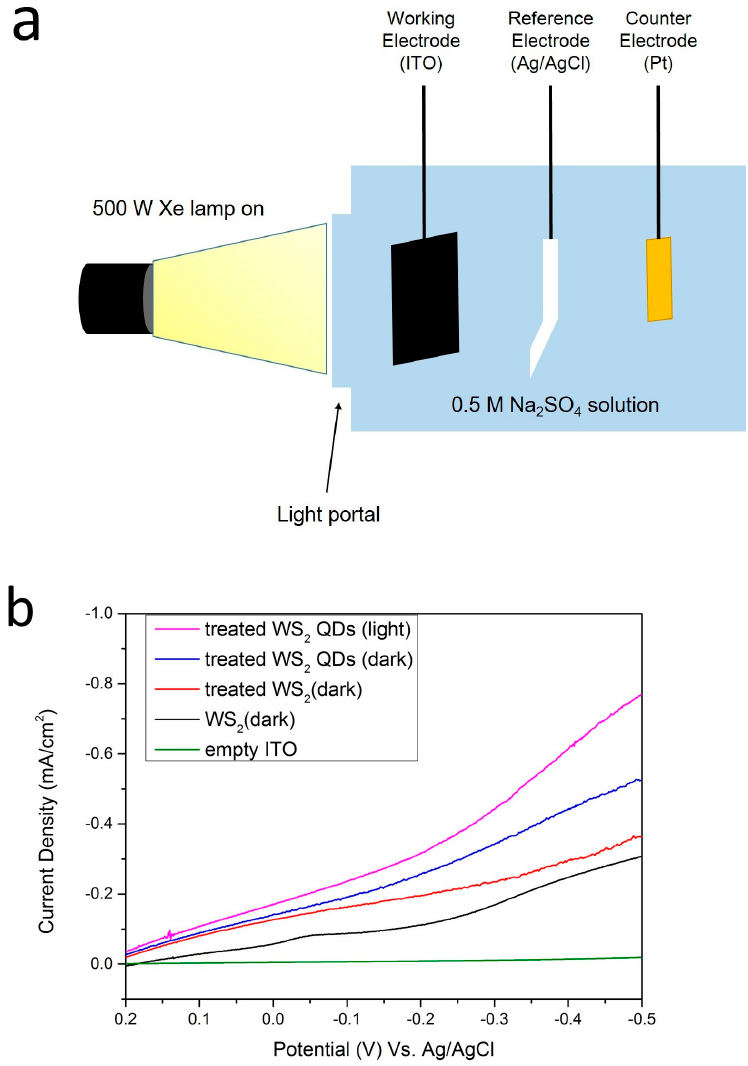
Figure 5. ( a ) Schematic diagram of photocatalytic measurement and ( b ) PEC (photoelectrochemical) activity of bulk WS 2 , sulfuration-treated WS 2 and treated WS 2 QDs (dark and under light), respectively.